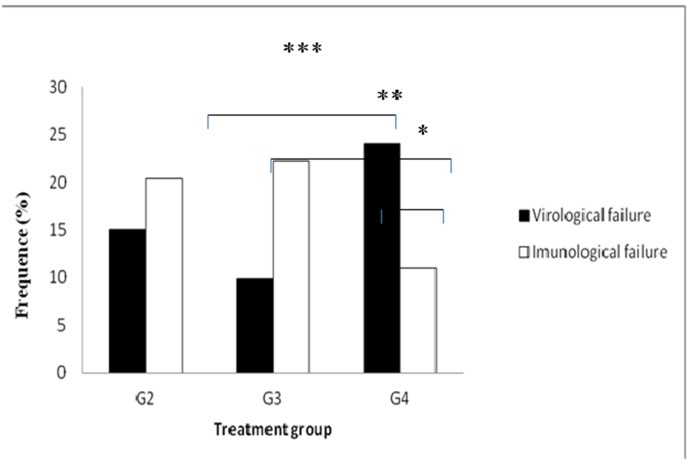
Prevalence of virological and immunological failure in HAART exposed groups (2 to 4).The lines above bars represent significant differences (p<0.05) calculated by Mann-Whitney test. ***Significant differences in IF between G3 and G4; **Significant differences in VF between G3 and G4; * Significant differences between IF and VF in G4.